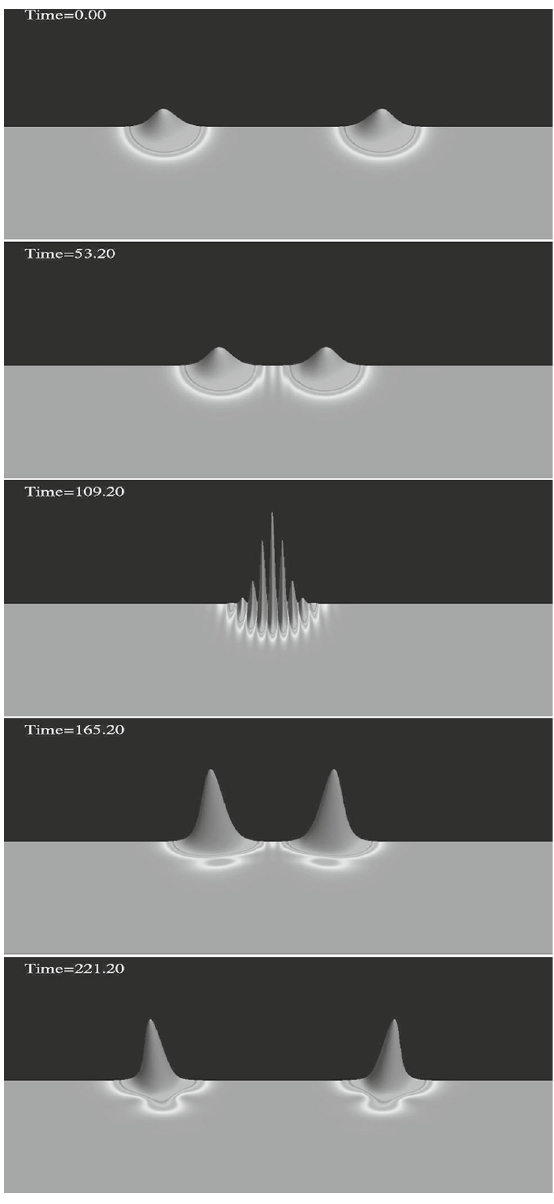
Fig. 1 Demonstration of the solitonic nature of the (mini-)boson star. Shown are snapshots of the magnitude squared of the complex scalar field for a head-on collision of two identical mini-boson stars. The interacting stars display an interference pattern as they pass through each other, recovering their individual identities after the collision. However, note that the BSs have a larger amplitude after their interaction and so are not true solitons. The collision can therefore be considered inelastic . Reprinted with permission from Choi et